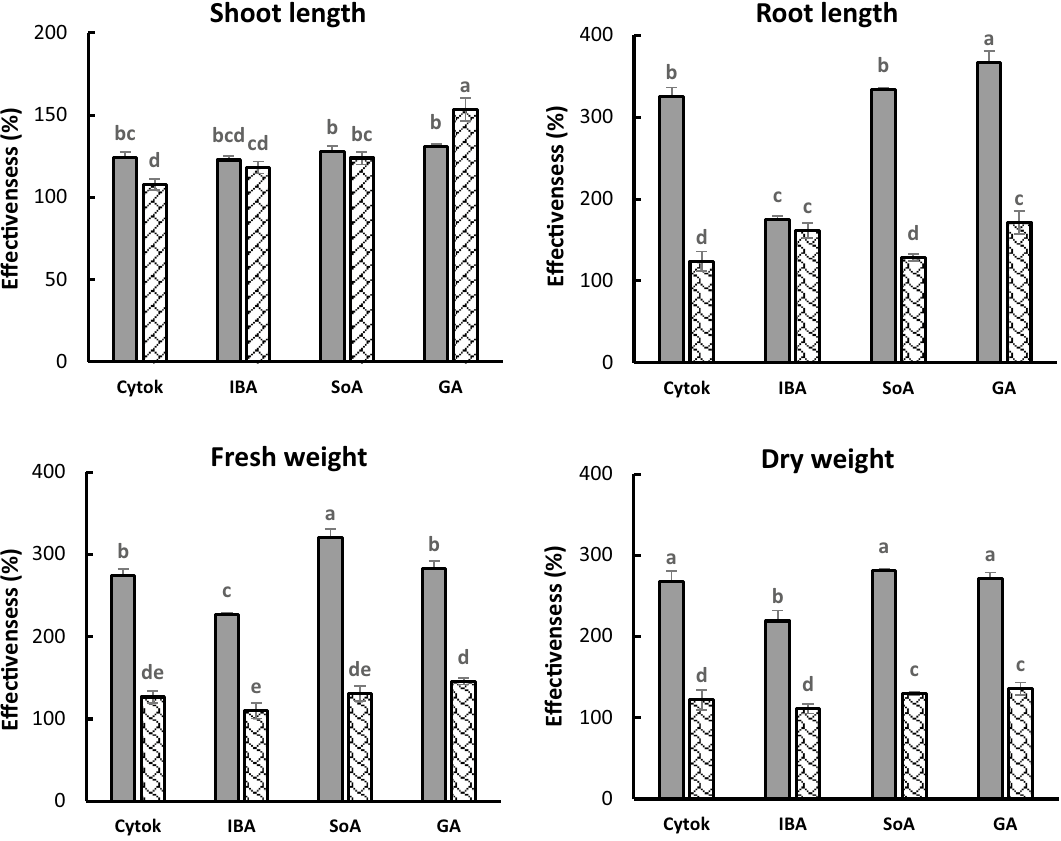
SoA Figure 1. Comparison between effect of chemical resistance inducers at their recommended rate applied by soil drench and foliar spray on growth parameters of tomato plants grown in Fusarium infested soil under greenhouse condition. Cyto cytokinin, IBA indole butyric acid, SoA sorbic acid, GA gibberellic acid. Different letters indicate significant differences among treatments in each growth parameter at P ≤